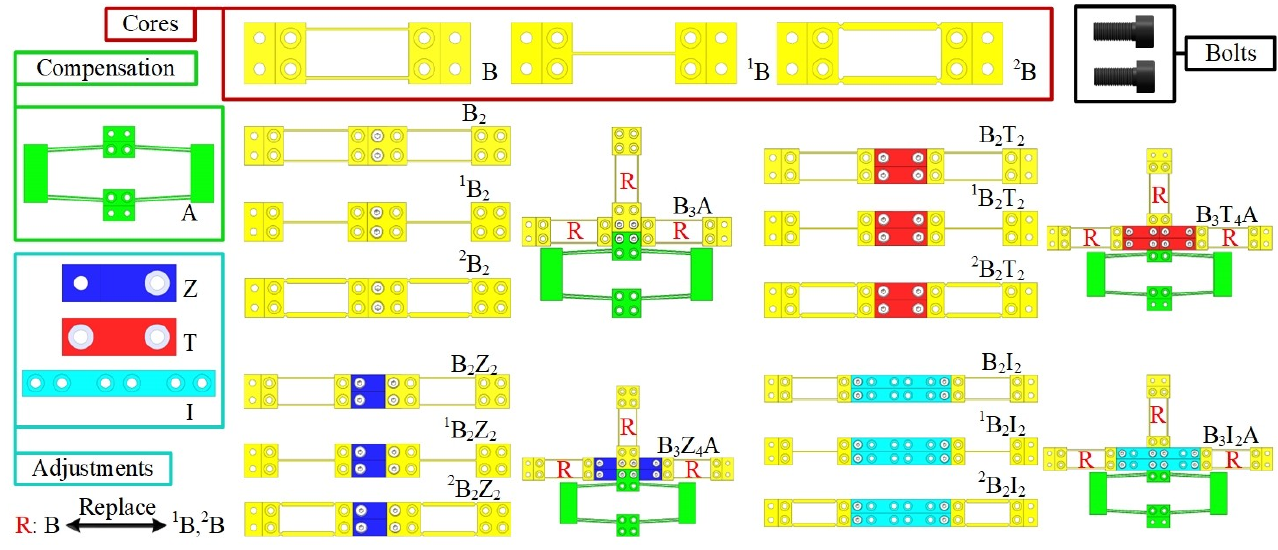
Figure 8. Assembly of one-DOF MPSs using standard modules.